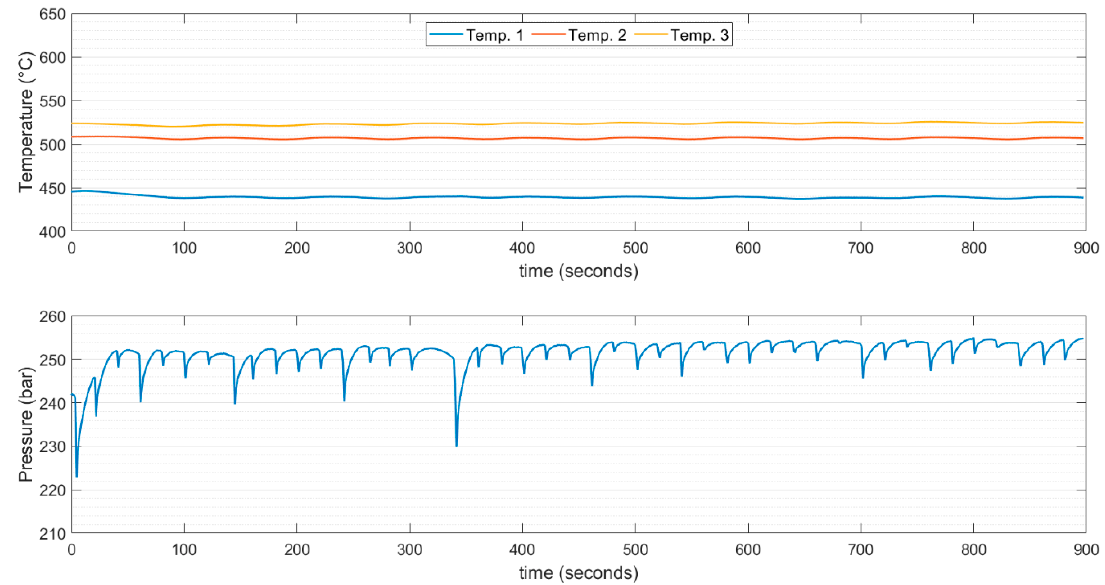
Figure 5. Temperatures and pressure values, recorded for the duration of one experiment at a set point temperature of 510 °C.